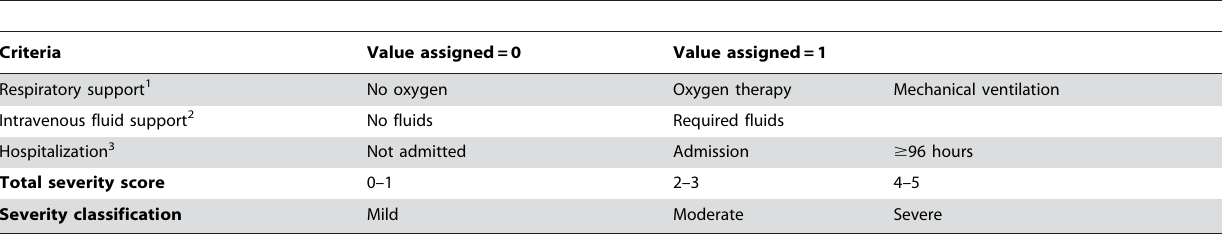
Table 1. Criteria used to determine the severity[60] of respiratory illness upon discharge, in patients presenting to Queensland hospitals who tested positive for HRV-QPM.